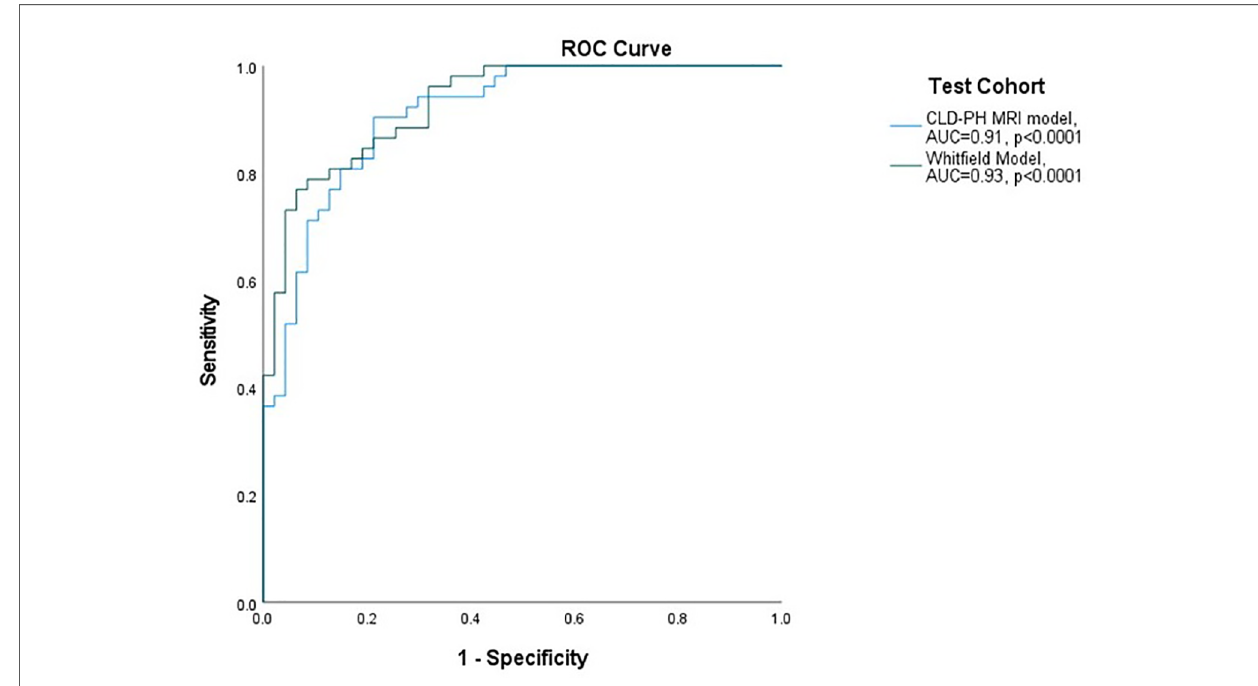
FIGURE 3 ROC curves for performance of models in severe PH (mPAP ≥ 35 mmHg OR mPAP >25 and CI < 2l/min/m 2 ). ROC: receiver operating characteristic curve; AUC: area under the ROC curve; mPAP: mean pulmonary artery pressure; CI: cardiac index; CLD: chronic lung disease; PH: pulmonary hypertension; MRI: magnetic resonance